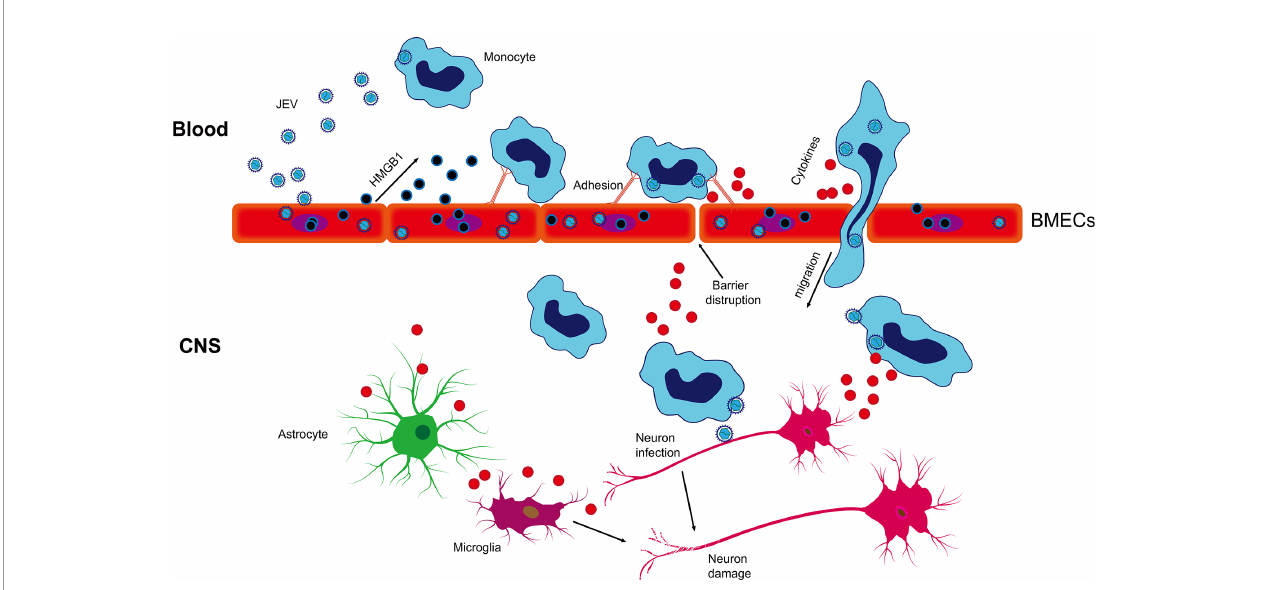
FIGURE 7 | Schematic description of BMEC-derived HMGB1 contributing to JEV-infected monocyte transendothelial migration. JEV induced HMGB1 release from BMECs and upregulated the expression of adhesion molecules, which showed enhanced leukocyte-endothelium adhesion accompanied by promoted JEV-infected monocyte transendothelial migration and BBB fl uctuation. JEV-infected monocytes acted as “ Trojan horses, ” inducing a positive effect on JE and glia activation and subsequently expanding neuronal infection, causing uncontrolled in fl ammatory cytokine production and neuronal damage, resulting in the appearance of JE